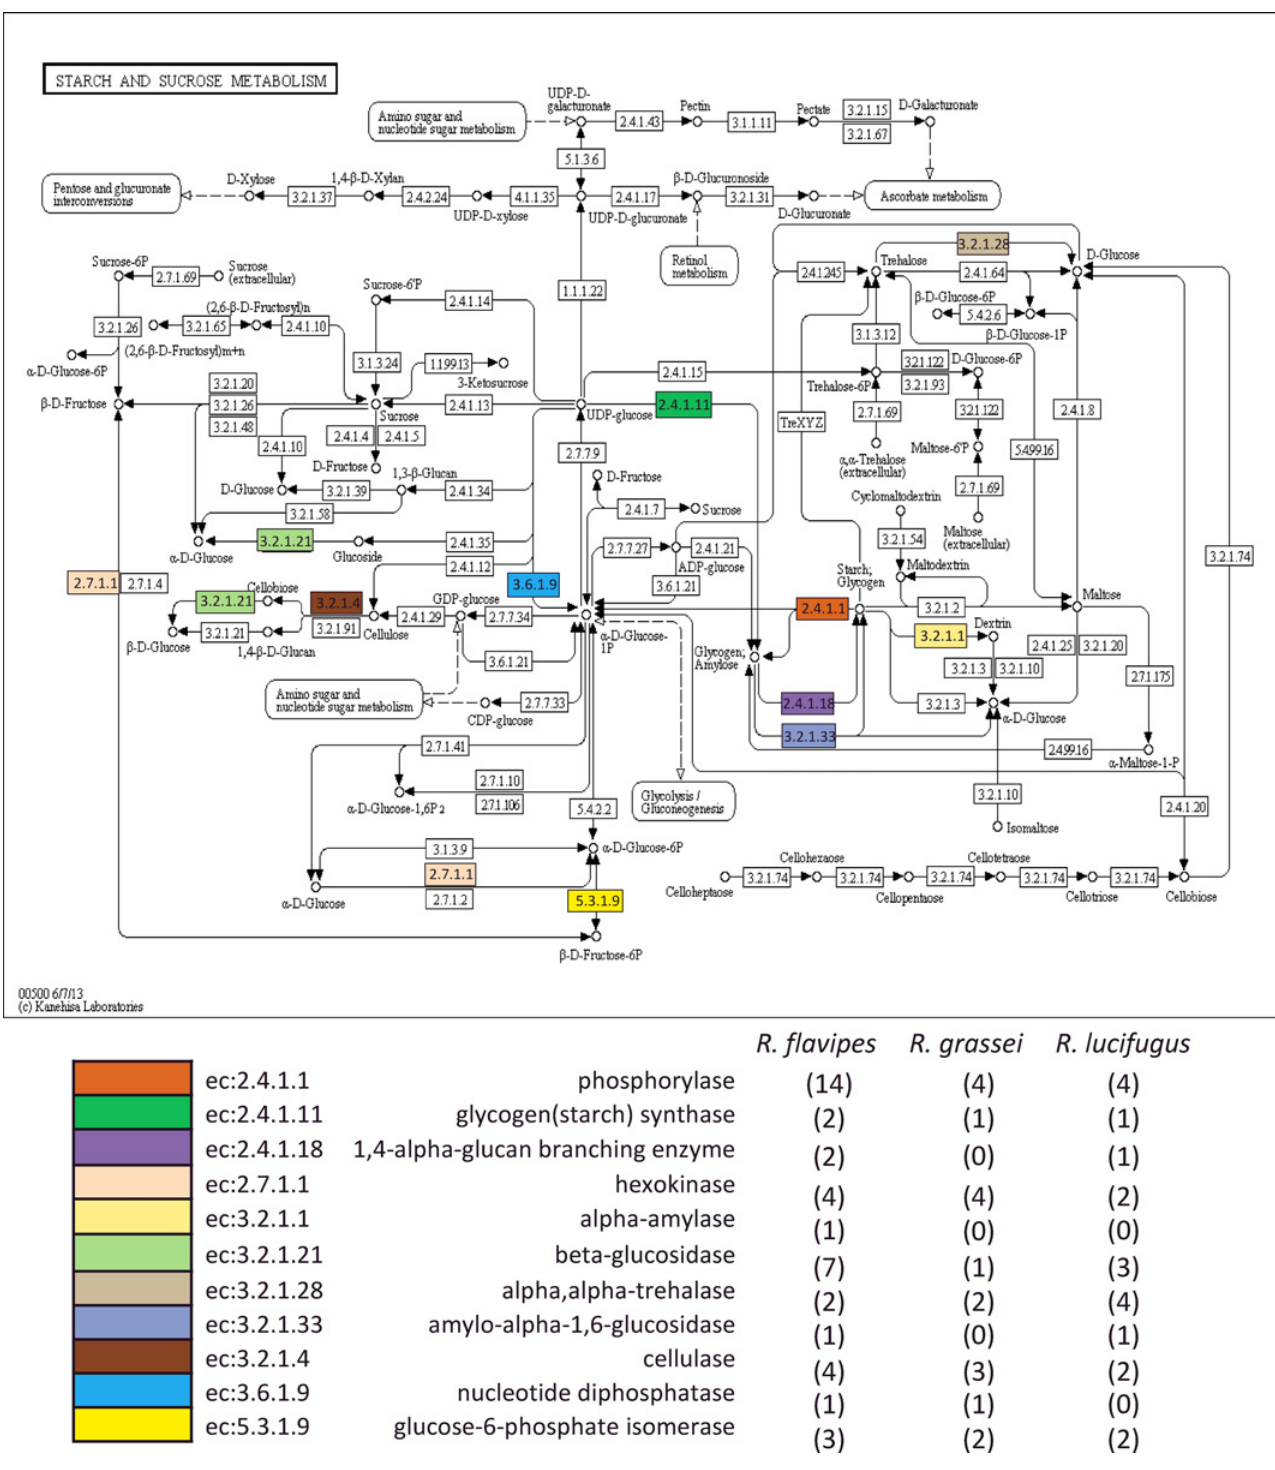
Fig 6. Contigs of R . flavipes , R . grassei and R . lucifugus displaying putative enzymatic activities involved in starch and sucrose metabolism. Top panel: termite contigs (colored boxes) mapped on the starch and sucrose metabolism KEGG map (black and white boxes). Bottom panel: number of contigs (brackets) associated to the 11 putative functions of starch and sucrose